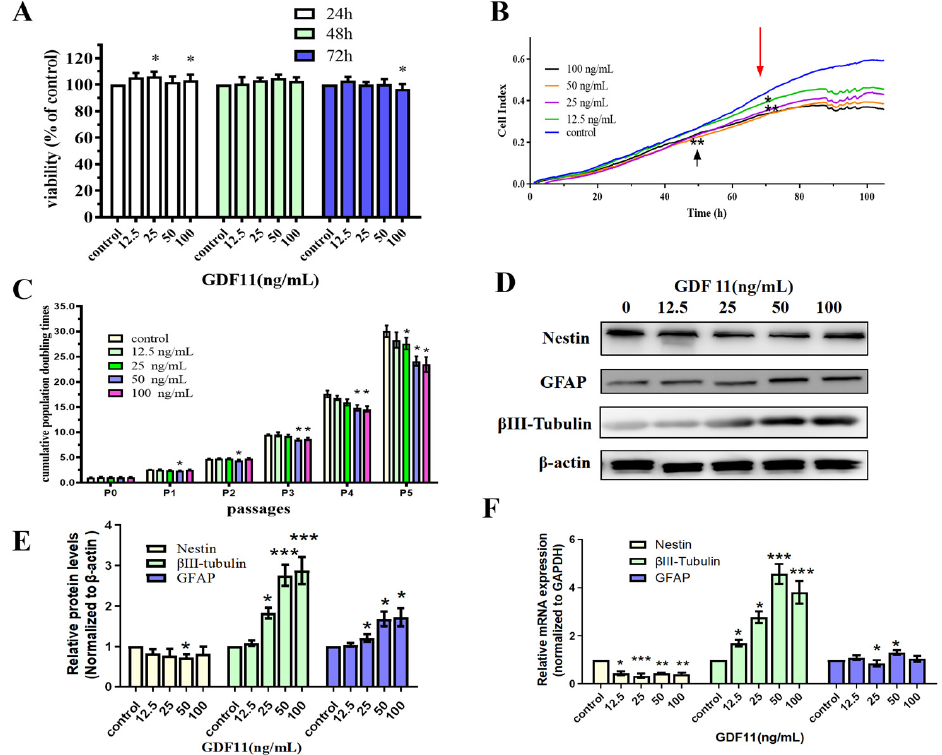
Figure 1. Effects of GDF11 on PC12 cells. ( A ) The viability of PC12 cells treated with various concentrations of GDF11 or vehicle for 24 h, 48 h, or 72 h was measured by CCK-8 assay. * p < 0.05. ( B ) Cell viability was real-time monitored by a real time cell analyzer (xCELLigence RTCA TP) for a 120 h-period. * p < 0.05, ** p < 0.01. ( C ) Accumulative population doubling times (PDTs) of PC12 cells treated with different GDF11 concentrations for a total period of 5 passages. * p < 0.05. ( D ) Protein levels of nestin, β III-tubulin and GFAP were altered when PC12 cells were treated with various concentrations of GDF11 (0, 12.5, 25, 50 and 100 ng/mL) for 72 h. ( E ) Quantitative analyses of protein expressions of ( D ) in relation to β -actin expression. * p < 0.05, *** p < 0.001. ( F ) Transcriptional levels of nestin, β III-tubulin and GFAP when PC12 cells were incubated with or without GDF11 for 5 h. * p < 0.05, ** p < 0.01, *** p <